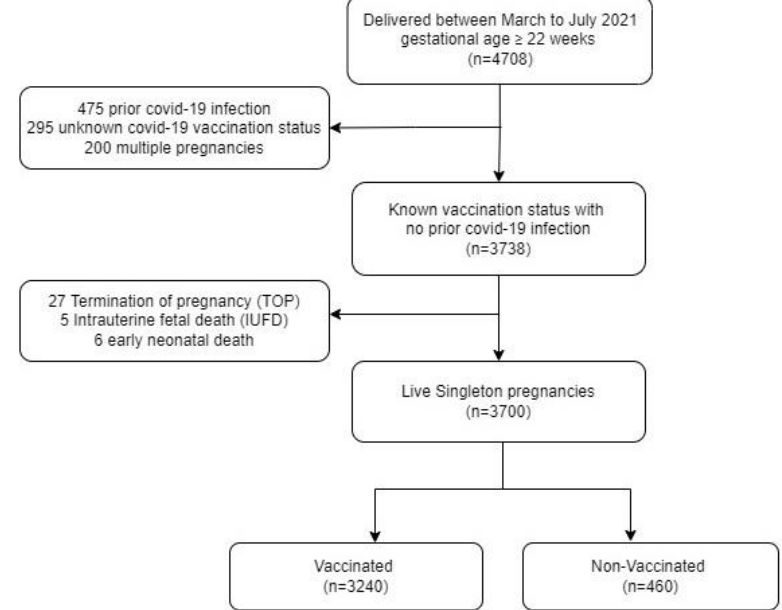
Figure 1. Cohort flow diagram. Inclusion criteria were as follows: (1) Women giving birth between March 2021–July 2021 with gestational age of at least 22 weeks; (2) Women with known vaccination status and no COVID-19 infection prior to giving birth; (3) Singleton live births.